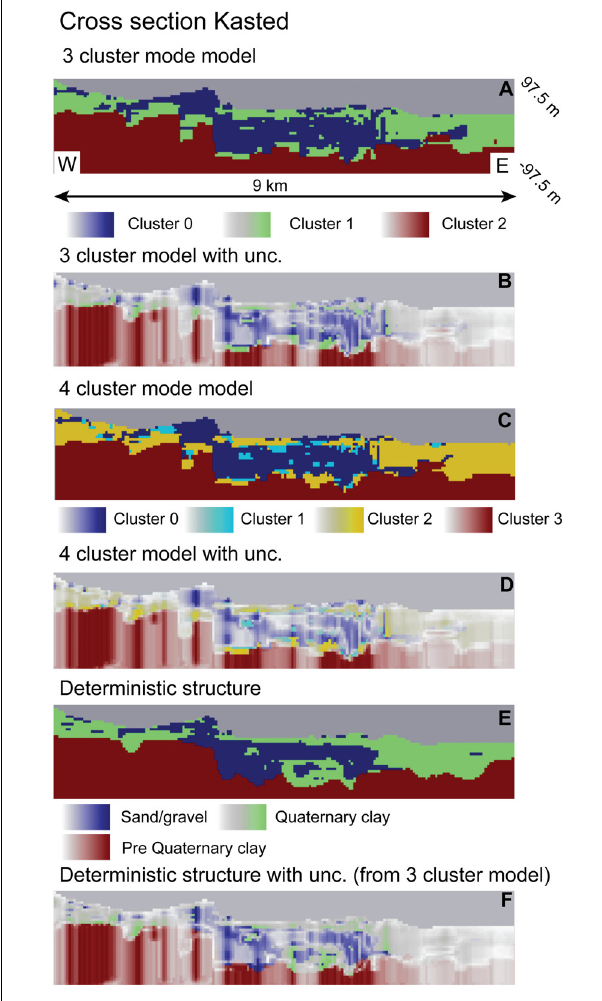
FIGURE 6 | Cross section through the Kasted model (see Figure 1 for location). (A) 3 cluster TI, (B) 3 cluster TI blanked with uncertainty, (C) 4 cluster TI, (D) 4 cluster TI blanked with uncertainty, (E) Deterministic structure, (F) Deterministic structure blanked with uncertainty from 3 cluster analysis.